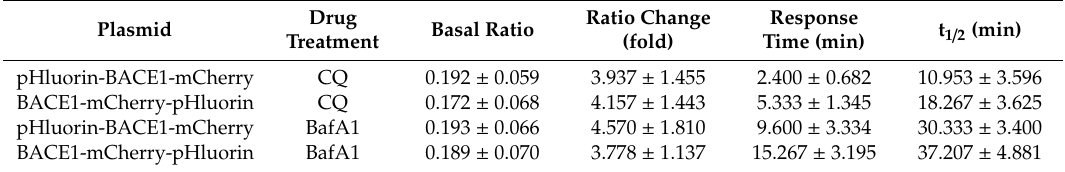
Table 2. Summary of BACE1 plasmids in response to CQ and BafA1 in cortical neurons.